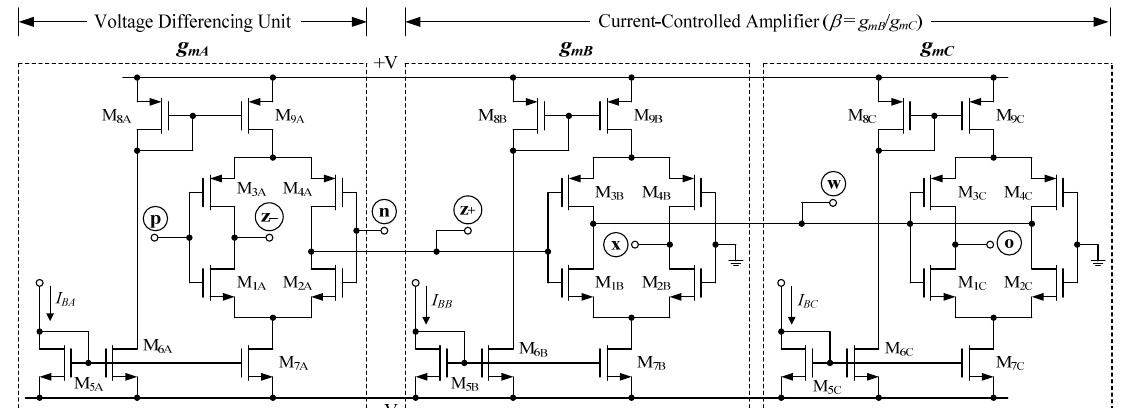
Figure 2. VDGA internal circuit implementation in CMOS technology.